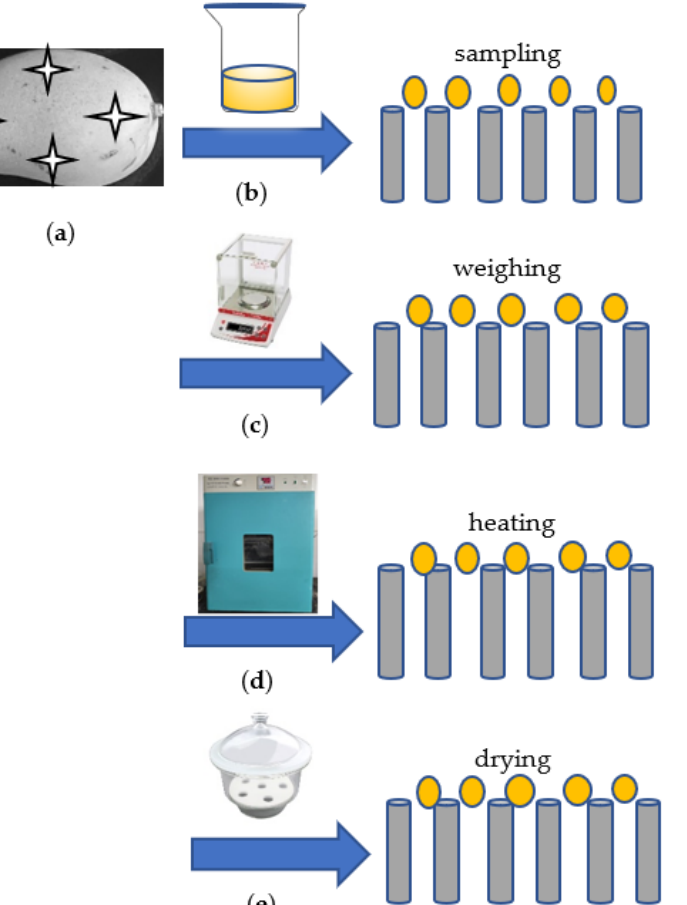
Figure 2. ( a ) The mango samples. ( b ) Flat weighing bottle made of glass ( c ) DHG-9240A electric constant temperature blast drying oven. ( d ) Dryer. ( e ) FA2304N electronic balance.